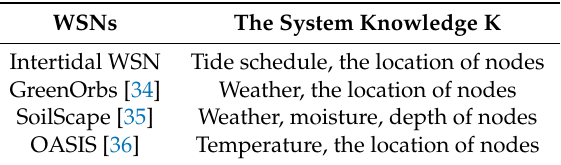
Table 2. The system knowledge K in different WSNs.